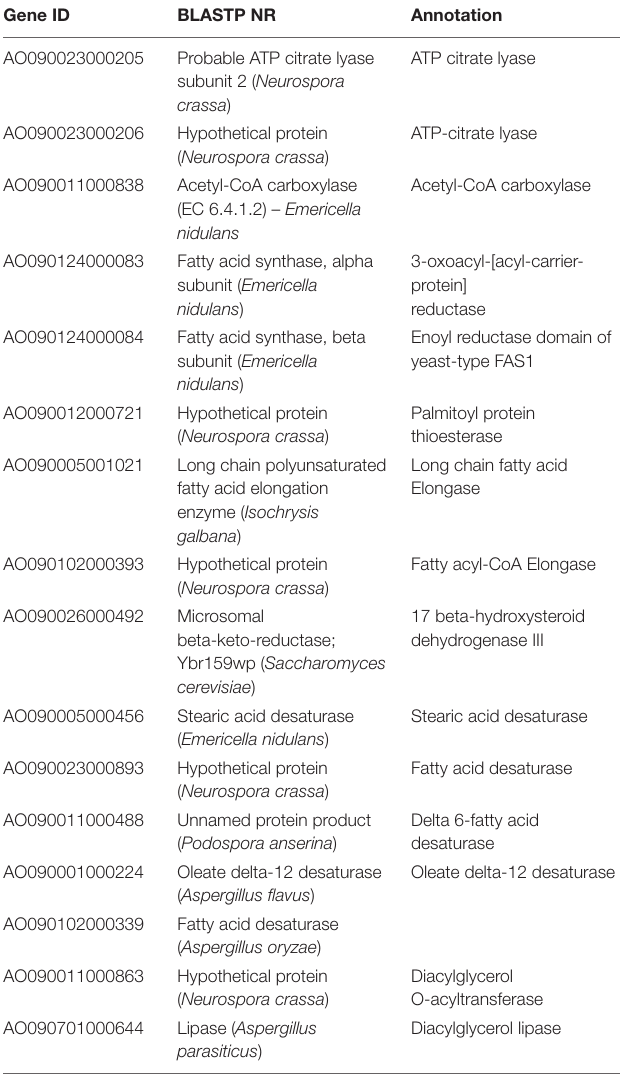
TABLE 1 | The FFA biosynthesis genes that were selected for gene